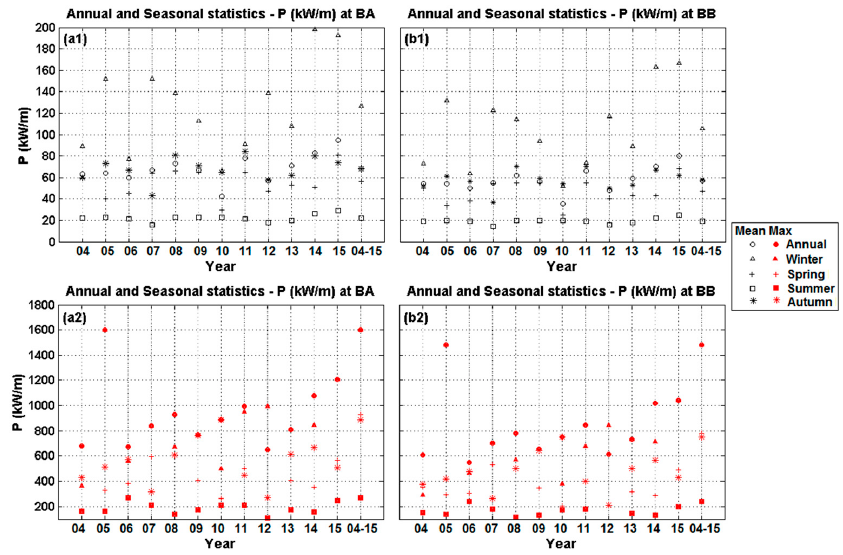
Figure 19. Summary statistics from annual and seasonal analyses of P (kW/m) for mean and maximum ( Max ) at ( a1 , a2 ) BA and ( b1 , b2 ) BB.